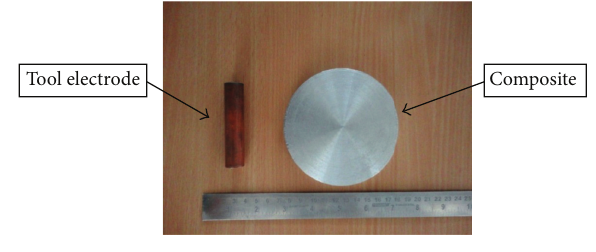
Figure 1: Prepared composite material.